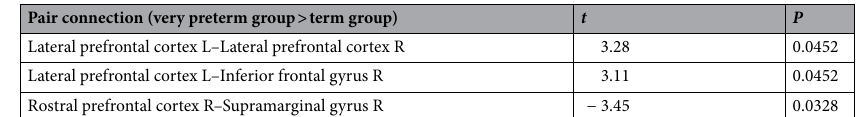
Table 3. ROI-to-ROI results showing functional connectivity differences between very preterm and term groups. Threshold ROI-to-ROI connections by intensity, false discovery rate of P < 0.05, two-sided. L, left; R,